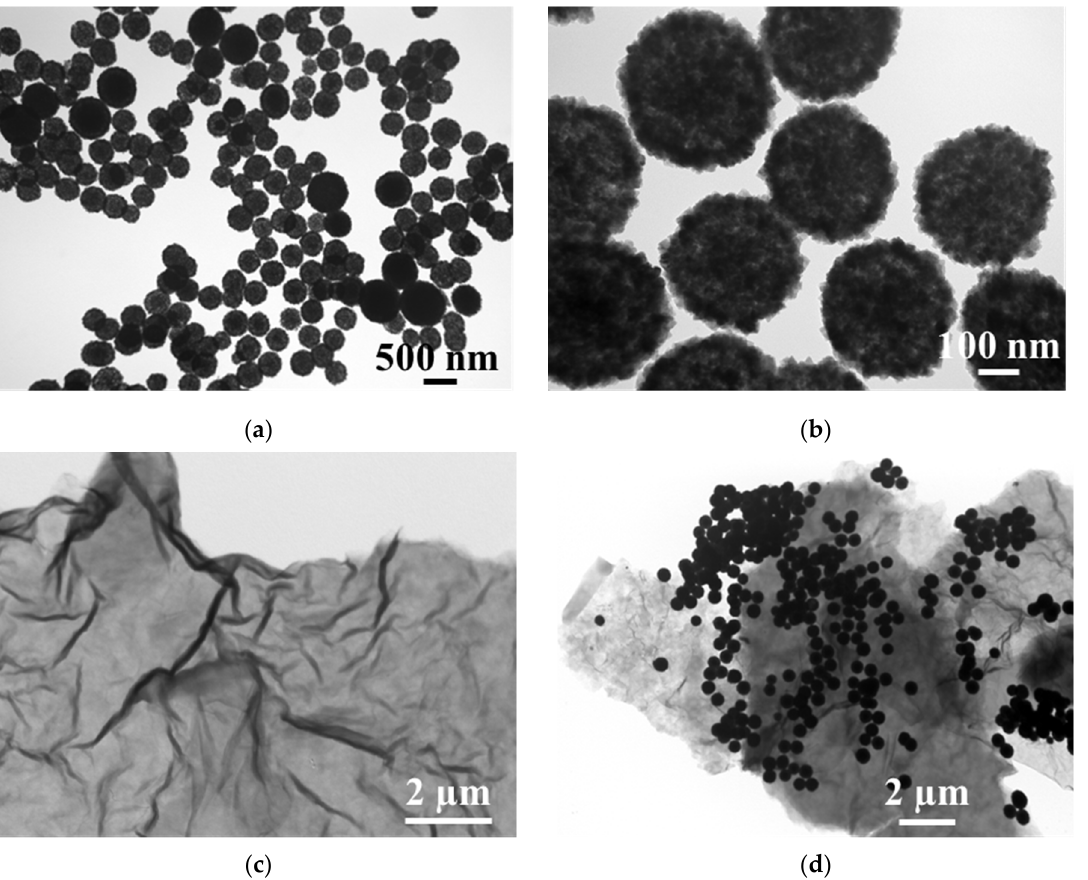
Figure 1. TEM images of ( a , b ) Fe 3 O 4 , ( c ) rGO and ( d ) Fe 3 O 4 -rGO nanocomposites. The XRD patterns of Fe 3 O 4 and Fe 3 O 4 -rGO are presented in Figure 2a. It can be